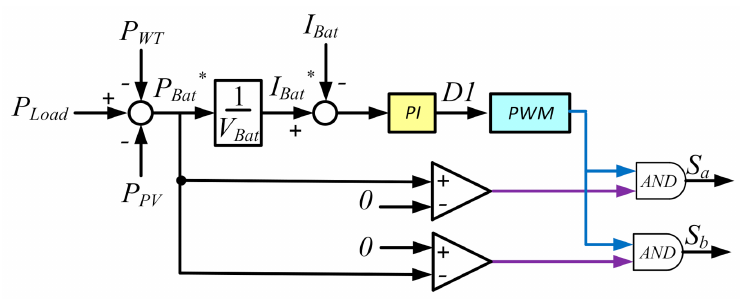
Figure 11. Control of switching signals for bidirectional DC/DC converter for battery